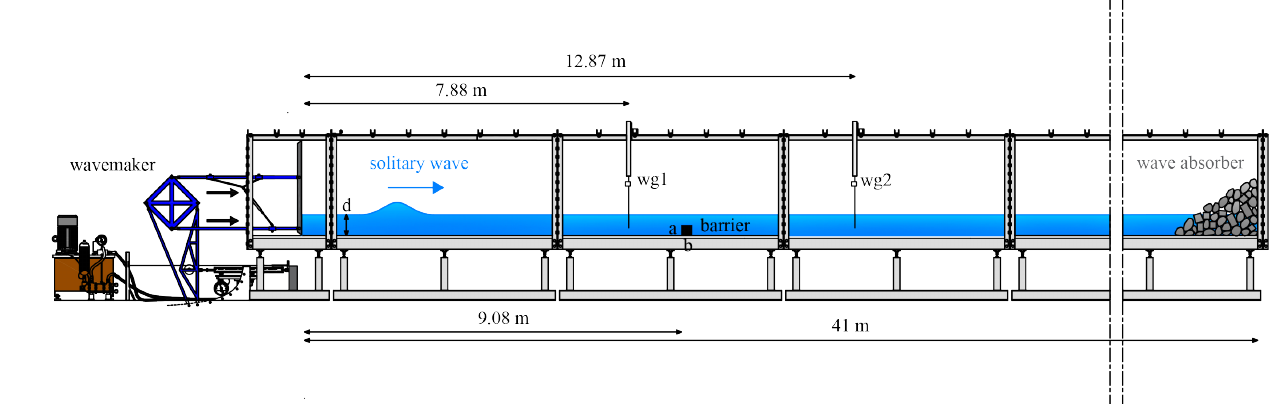
Figure 1. Longitudinal profile of the adopted experimental set-up.